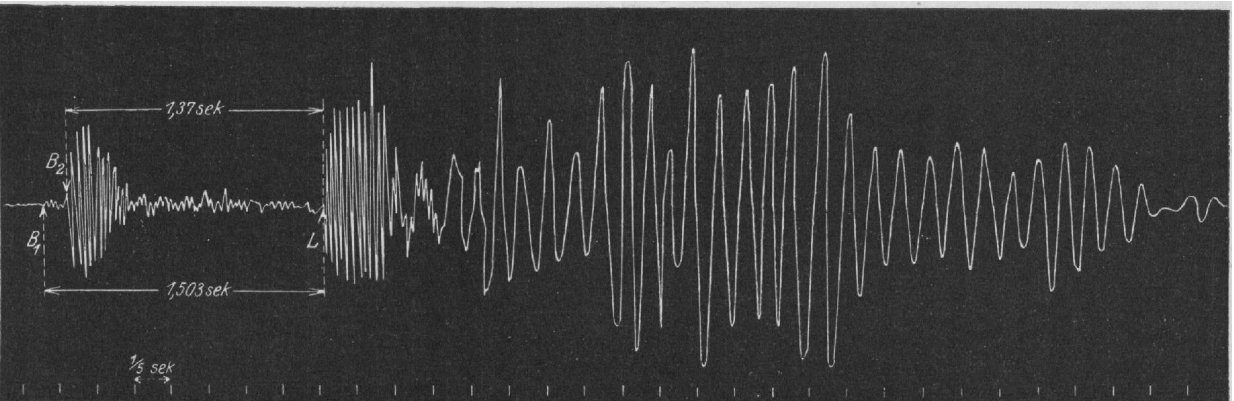
Figure 4. Seismic signal recorded by Karl Almstedt with Mintrop’s portable seismometer at a distance of 900m from a 13cm artillery gun (reproduced from Hort, 1922, p.